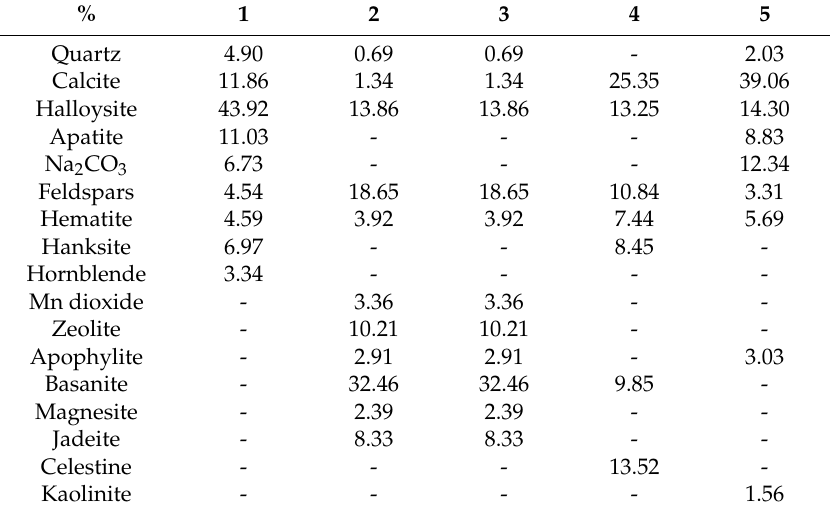
Table 2. Mineralogical composition (%) of five historical mortars (%) obtained by